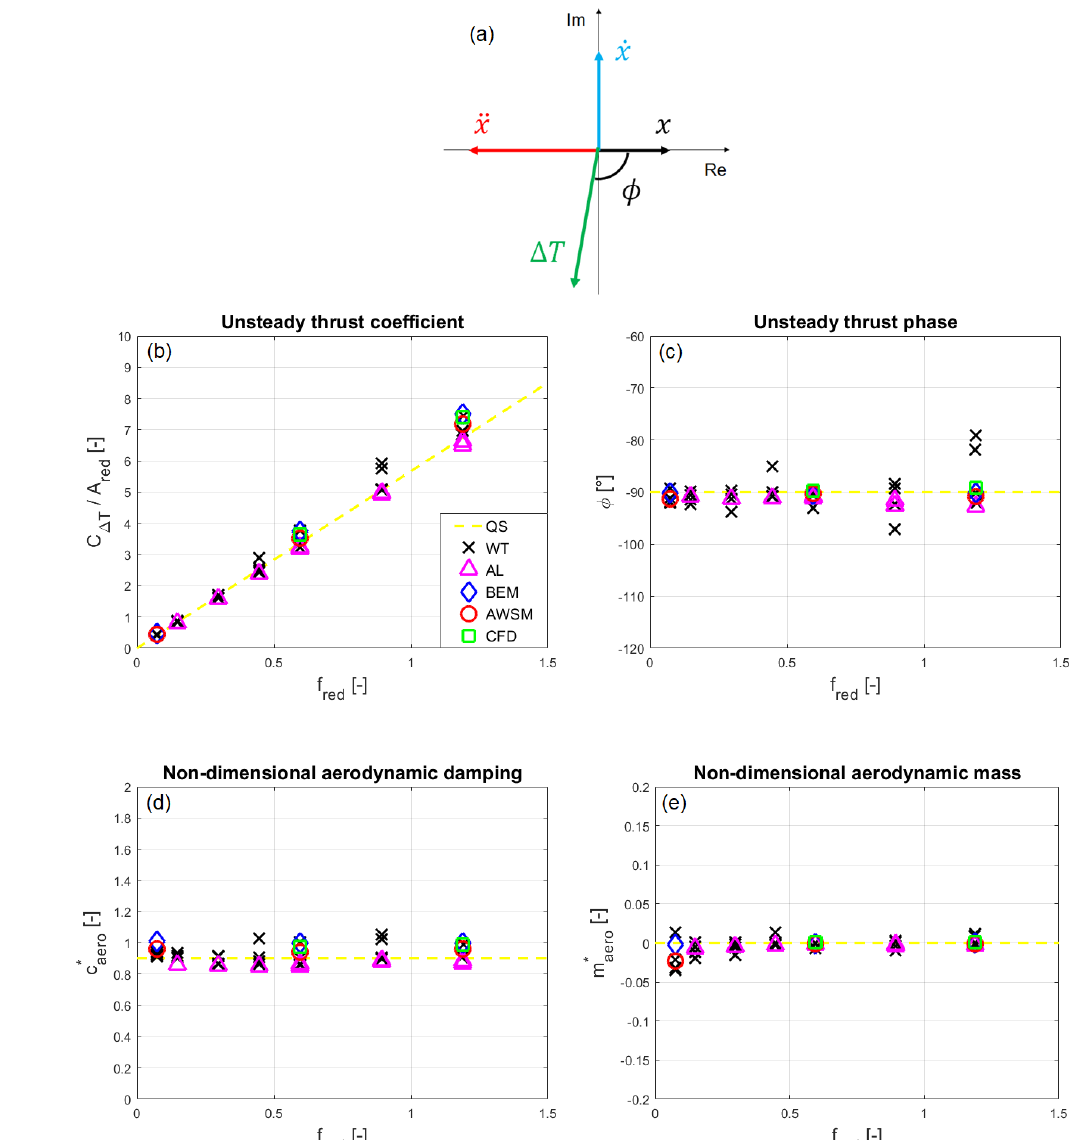
Figure 9. Complex representation of the surge harmonic of the thrust oscillation (a) , unsteady thrust coefficient comparison (b) , comparison of the phase of the surge harmonic of the thrust oscillation (c) , aerodynamic damping comparison (d) , aerodynamic mass comparison (e)